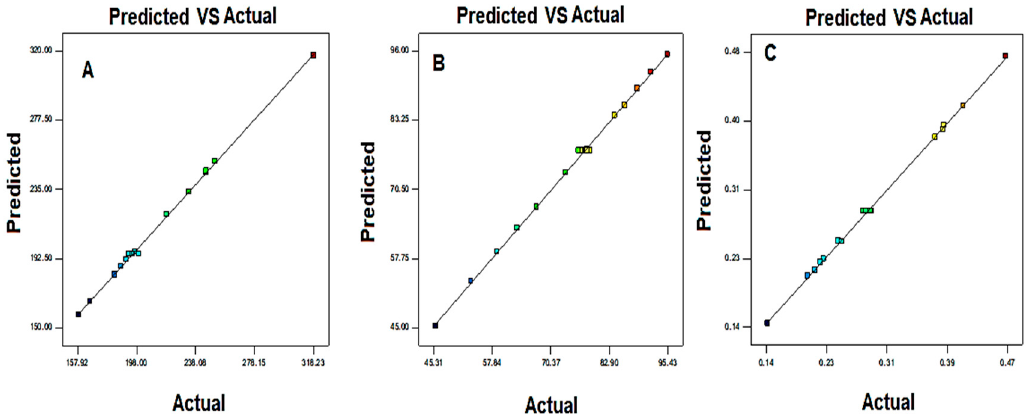
Figure 5. Actual and predicted images of ( A ) hydrodynamic diameter (Y 1 ), ( B ) entrapment efficiency (Y 2 ), and ( C ) PDI (Y 3 ). Color full square indicated the actual and predicted data of the